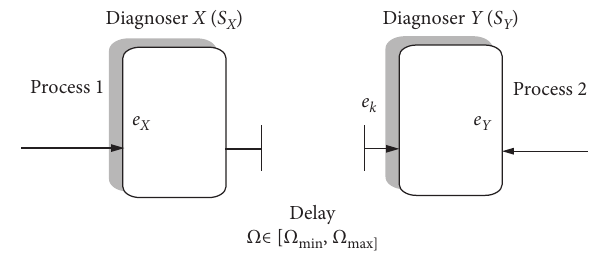
Figure 5: Operating delays between monitoring sites.